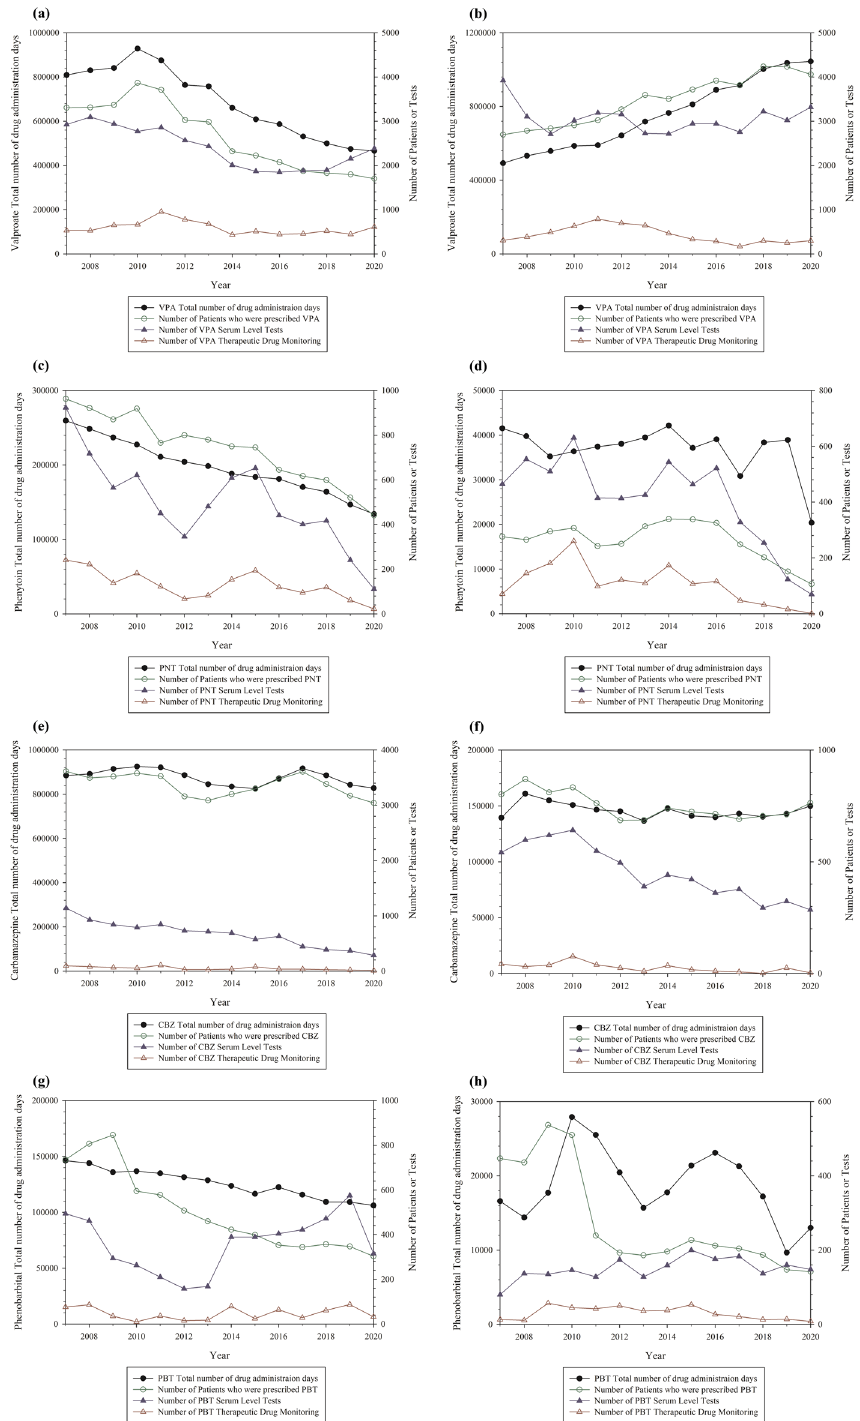
Figure 4. Analysis of the total number of drug administration days and the cases of serum level tests and therapeutic drug monitoring by year in Seoul National University Hospital or Seoul National University Bundang Hospital (Antiepileptic drugs: valproate, phenytoin, carbamazepine, and phenobarbital). ( a ), ( c ), ( e ), ( g ) for Seoul National University Hospital and ( b ), ( d ), ( f ), ( h ) for Seoul National University Bundang Hospital. The left y-axis represents the total number of drug administration days and the right y-axis represents the number of patients who were prescribed drugs and the number of serum level tests or therapeutic drug monitoring. Abbreviation: VPA, valproate; CBZ, carbamazepine; PNT, phenytoin; PBT,